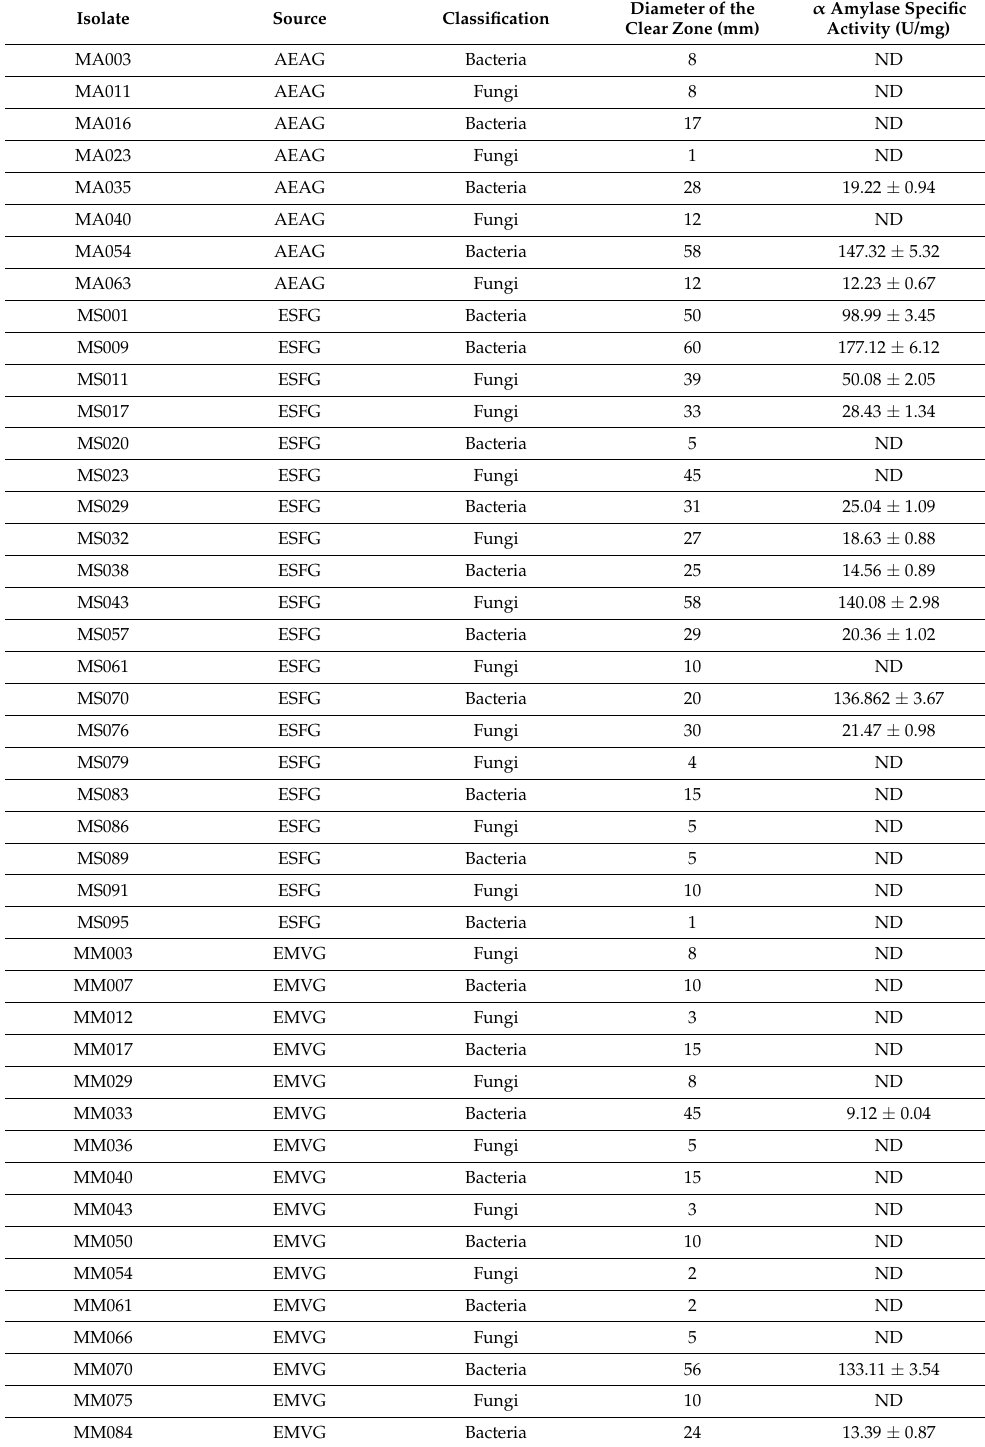
Table 3. Diameter of the clear zone produced by potential alpha-amylase producers in the starch iodine test, and the alpha-amylase-specific activity detected by the DNS